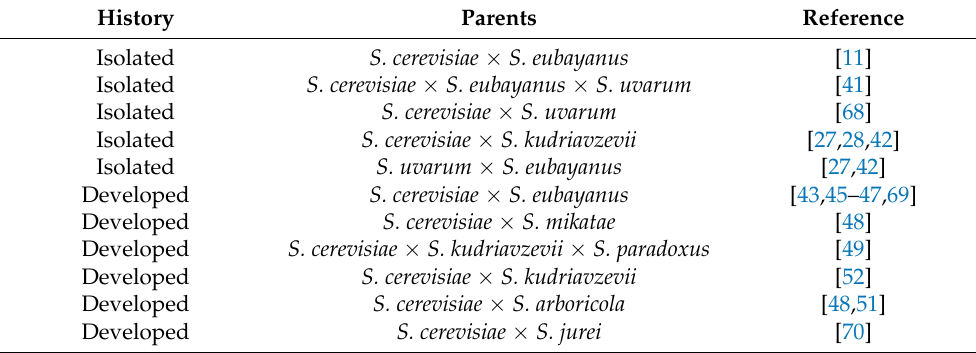
Table 2. Interspecific Yeast Hybrids in